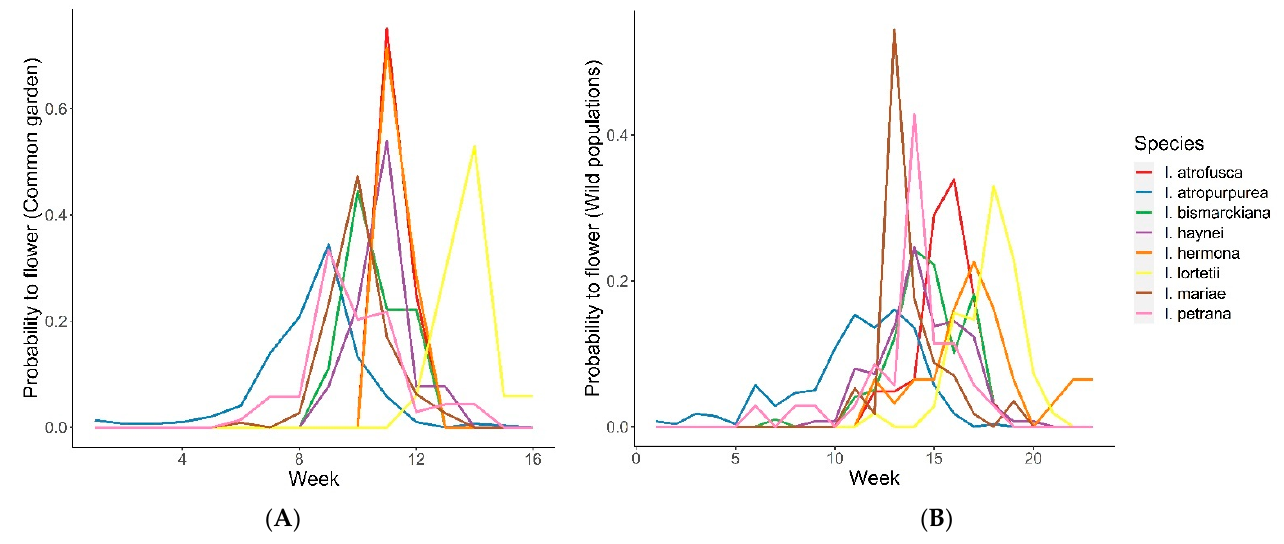
Figure 3. Flowering time, expressed as the probability of flowering in ( A ) common garden conditions in TAUBG, and ( B ) observations from wild populations.